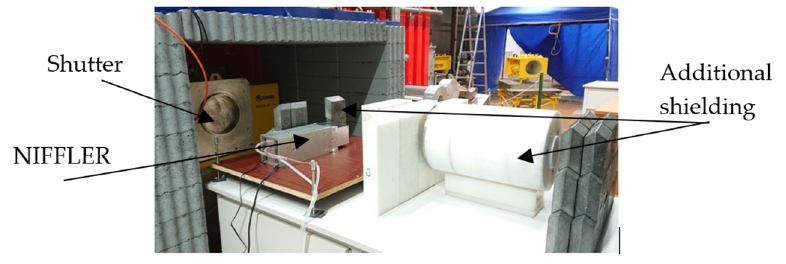
Figure 3. A photo of NIFFLER facility at the reactor VR-1.